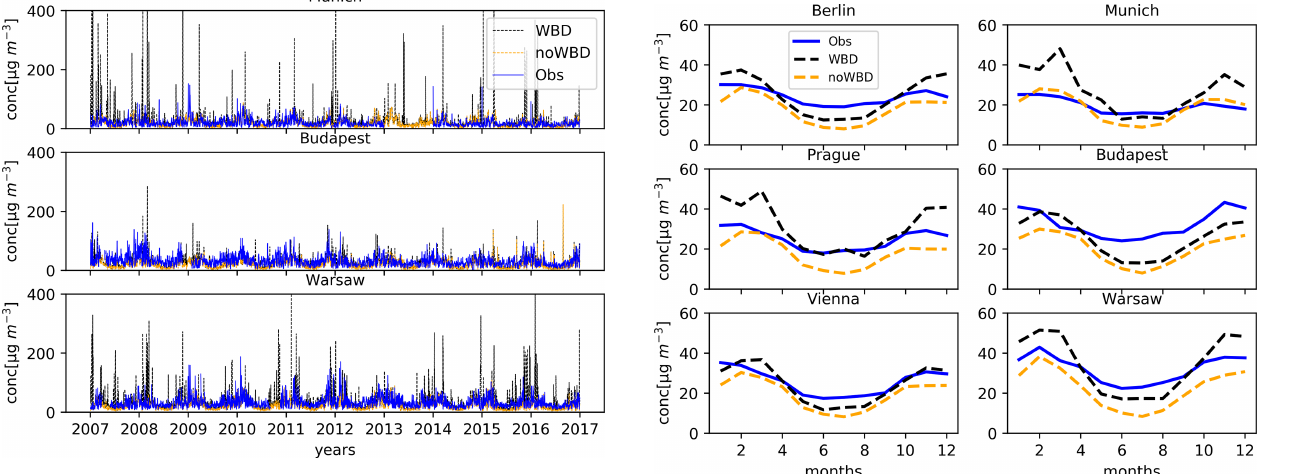
Figure 15. Annual cycle of monthly PM 10 concentrations of the WBD (dashed blue lines) and noWBD (dashed orange lines) simu- lations and the AirBase dataset (solid blue lines) for